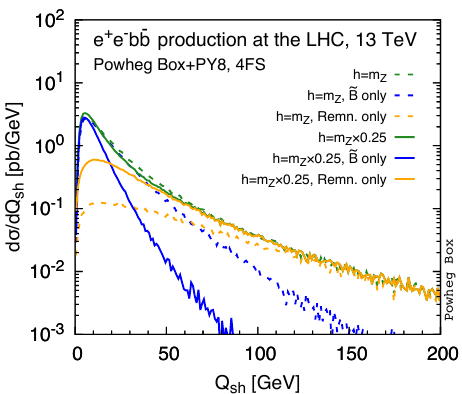
Figure 3 . Probability distributions of the shower scale Q sh (i.e. SCALUP ) in various event samples generated by the POWHEG-BOX